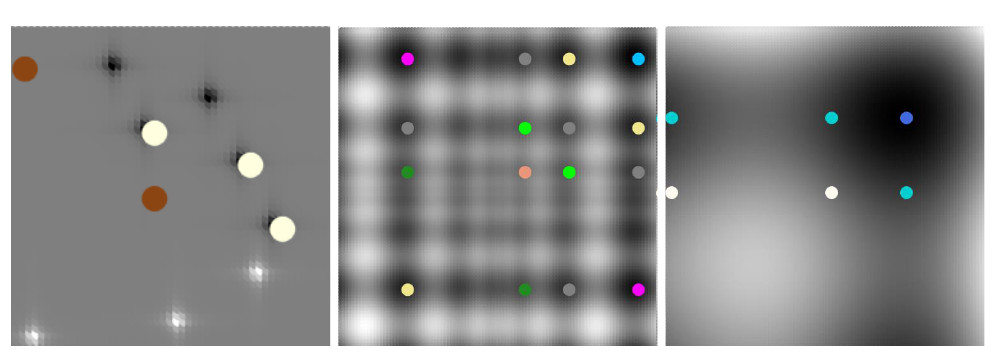
Fig. 2. Rastrigin TF. N =15, a =0.95. Fig. 3. Rosenbrock TF. N =4, a =0.999. Fig. 4. Himmelblau TF. N =4, a =0.8.